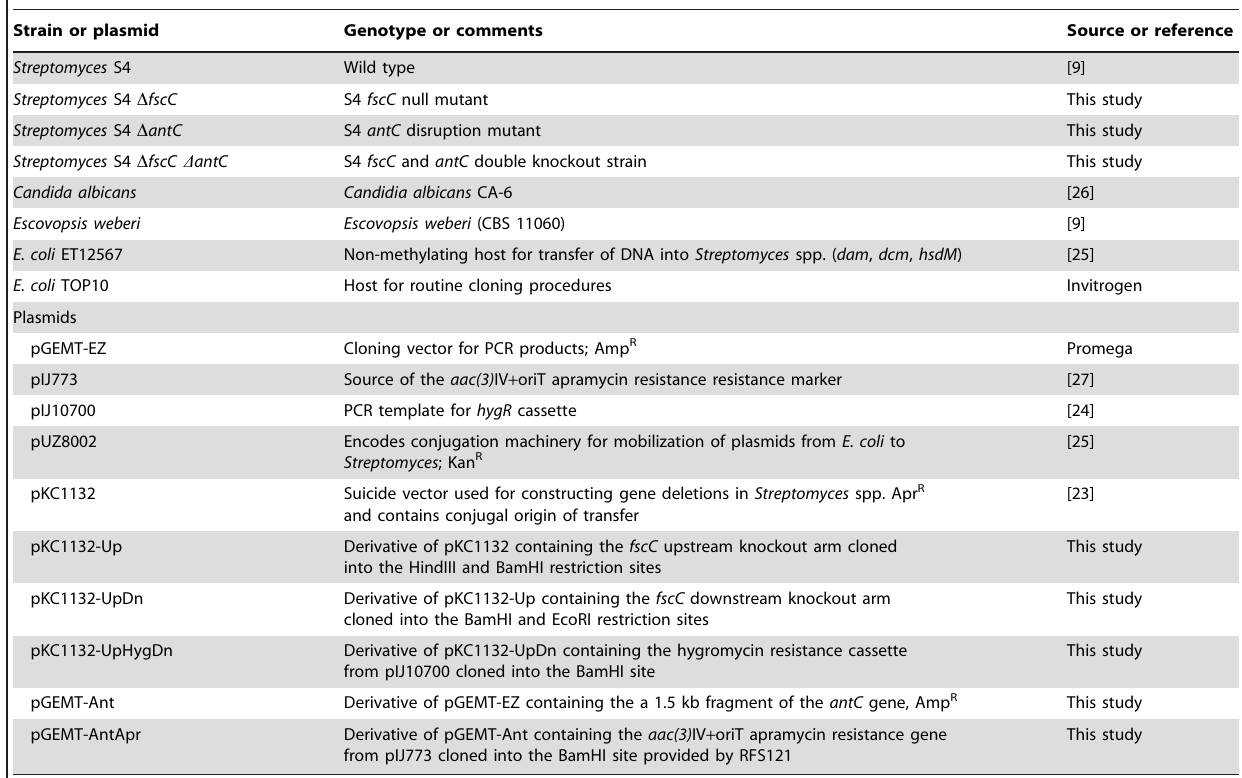
Table 3. Strains and plasmids used in this